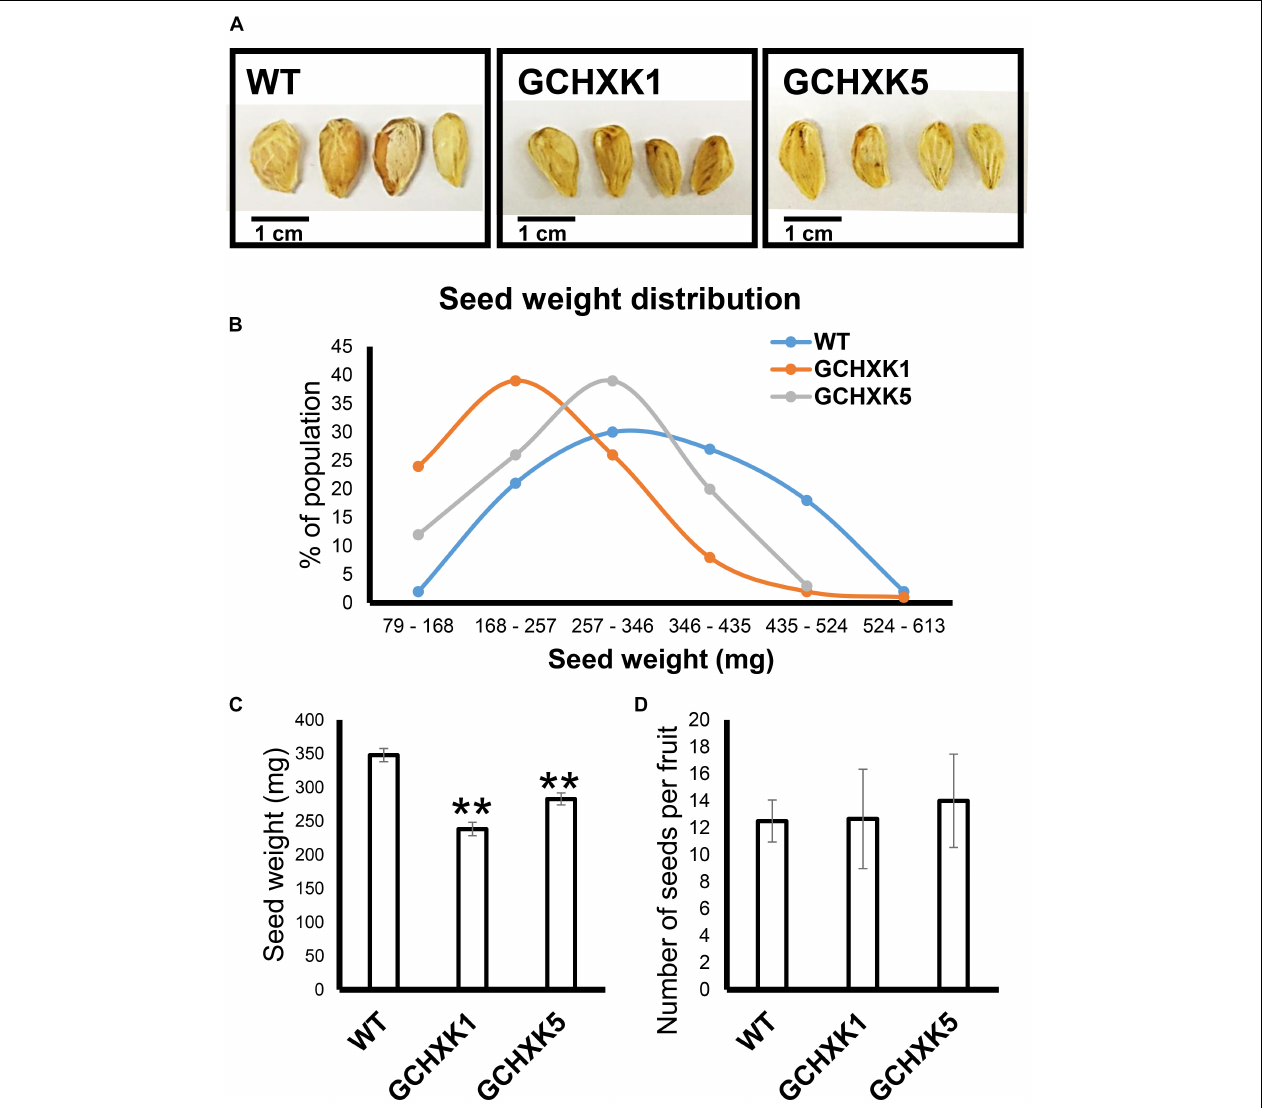
FIGURE 8 | GCHXK citrus plants produce smaller seeds. Seed weight was determined by weighing 100 individual seeds from the GCHXK1, GCHXK5, and WT plants. (A) Representative images of WT, GCHXK1, and GCHXK5 seeds. (B) Weight distribution of the seeds. (C) Average weights of the WT, GCHXK1, and GCHXK5 seeds. (D) Number of seeds per fruit (for WT and GCHK1, n = 6 fruits; for GCHXK5, n = 3 fruits). Data are displayed as means ± SE. Asterisks denote significant differences relative to the WT ( t -test, P <